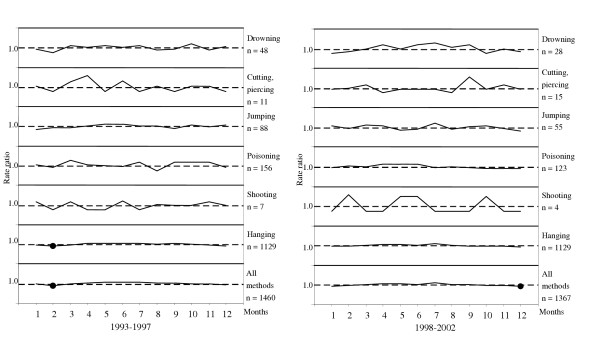
The monthly ratios of suicides by method among Lithuanian women. Statistically significant peaks are dark-dotted.